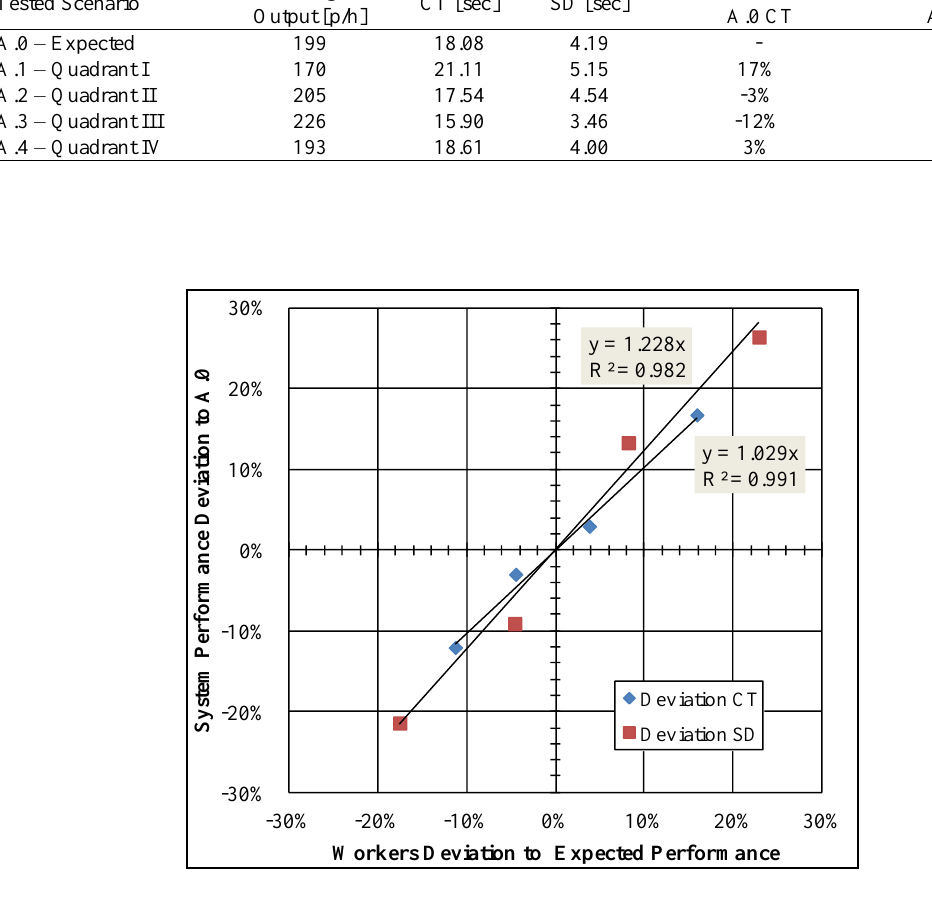
Figure 5. Relation between workers deviation to expected performance and system output for Scenarios A